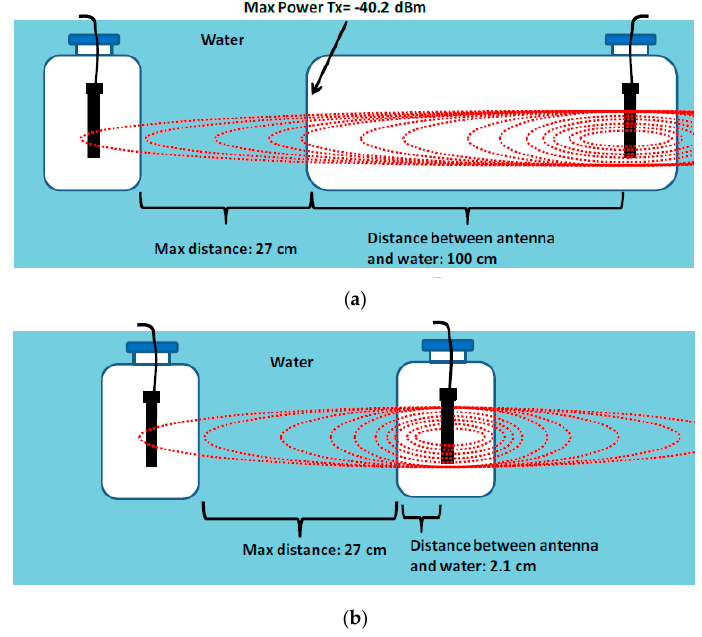
Figure 6. Preliminary test to check the effect of air gap. ( a ) distance between antenna and water: 100 cm; ( b ) distance between antenna and water: 2.1 cm.